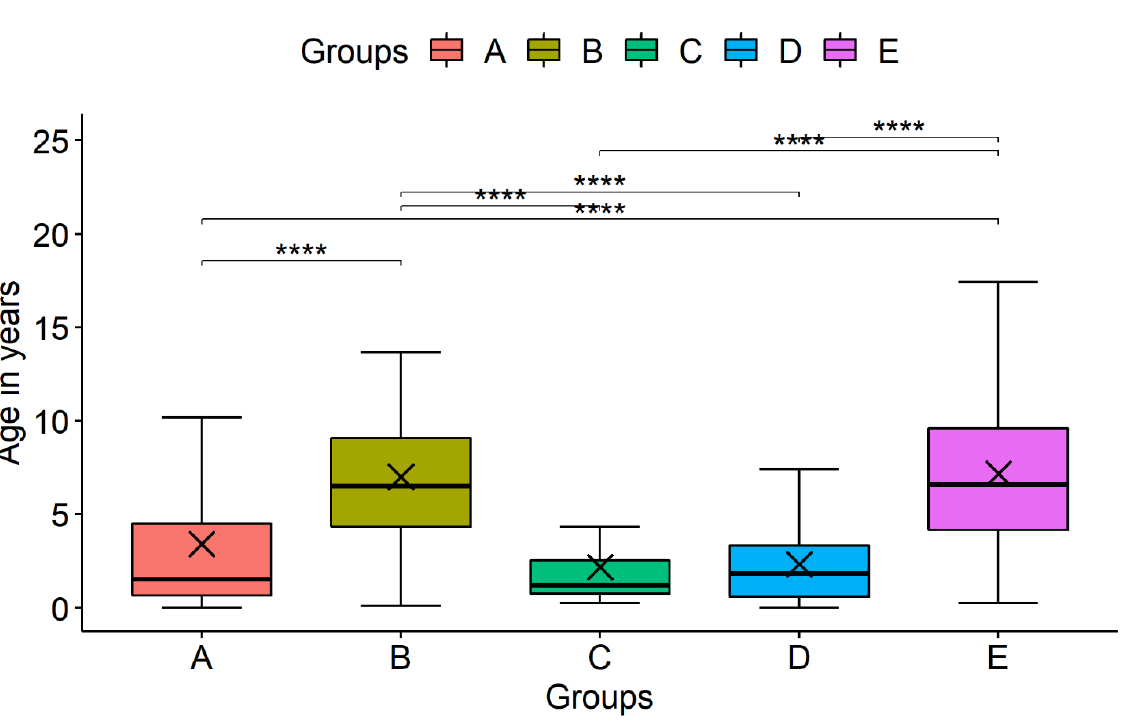
Figure 2. Comparison of age distribution in Groups A–E. **** p < 0.001, except between A and C; A and D; B and E; C and D groups. Group A: SARS-CoV-2; Group B: SARS-CoV-2 and influenza A/B; Group C: SARS-CoV-2 and RSV; Group D: RSV; Group E: influenza A/B.